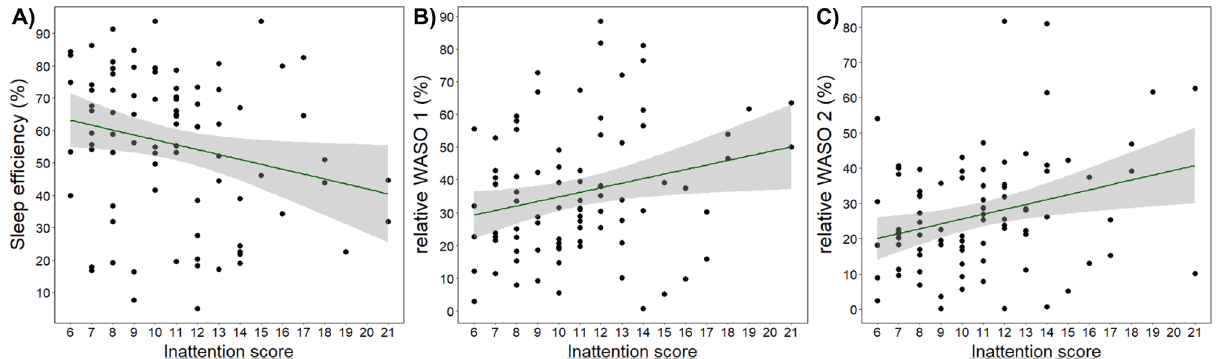
Figure 3. Visualization of Kendall’s rank correlations that showed non-significant tendency between ADHD inattention score and ( A ) sleep efficiency ( τ b = −0.172, corr. p = 0.062), ( B ) WASO 1 ( τ b = 0.164, corr. p = 0.073) and ( C ) WASO 2 ( τ b = 0.181, corr. p = 0.053) after controlling for multiple correlations (Benjamini–Hochberg). Shaded areas indicate confidence intervals.